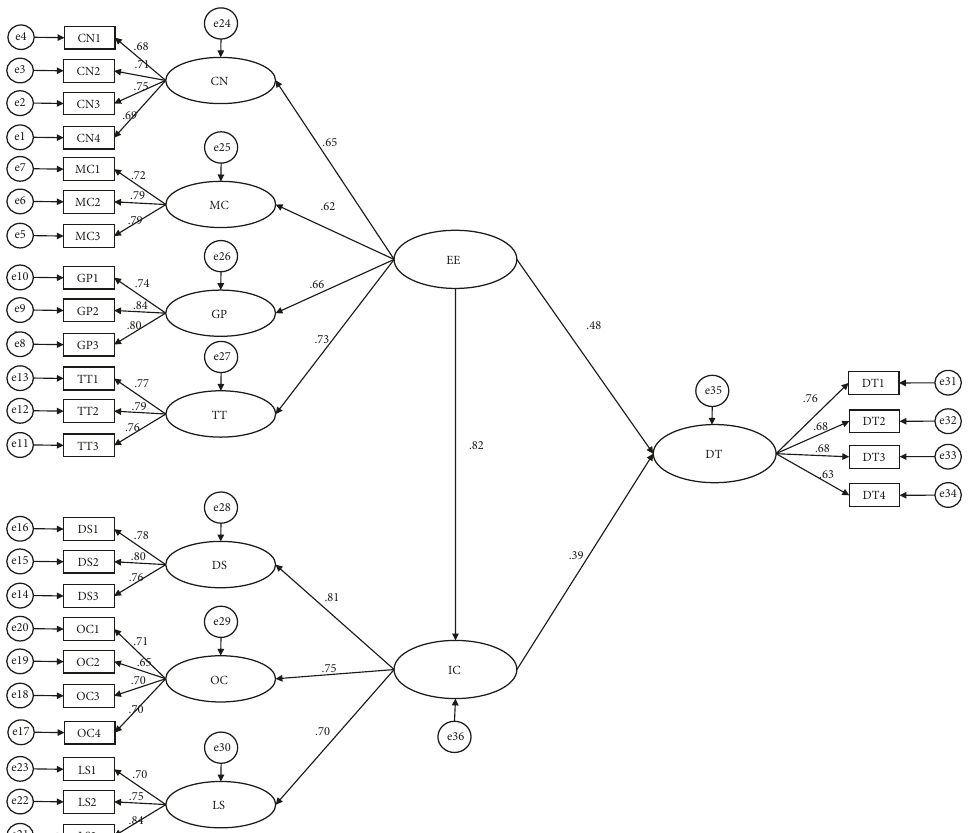
Figure 5: Influencing factor model of pharmaceutical enterprises’ DT